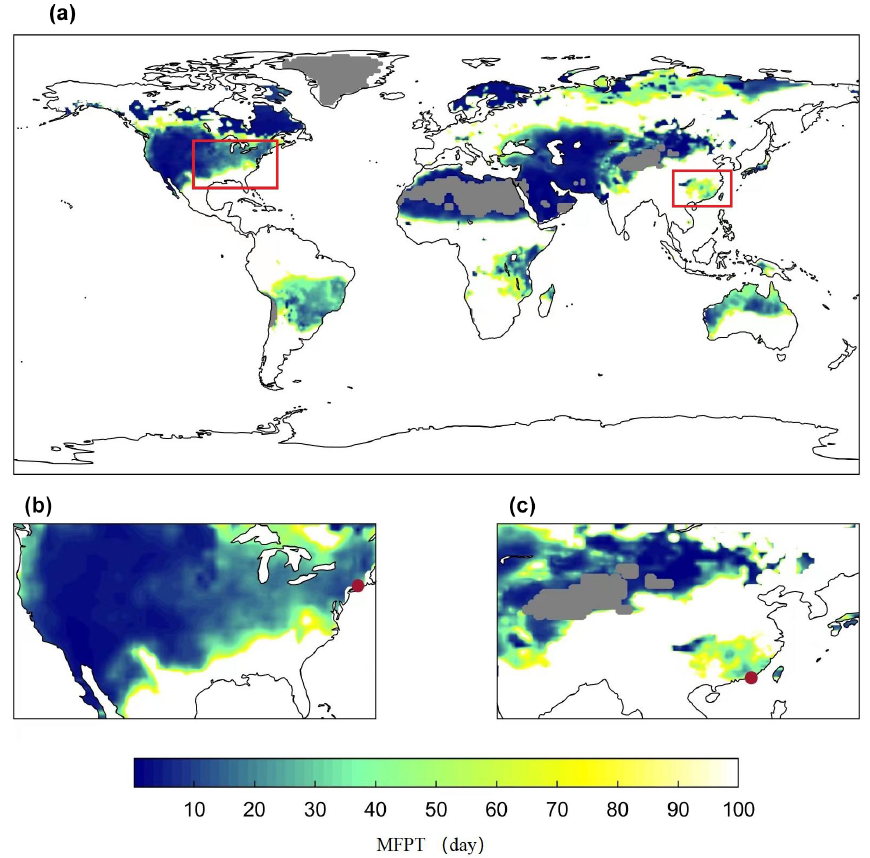
Figure 4. Global distribution of the mean first passage time (MFPT) in summer. The red boxes in panel (a) indicate the magnified areas in panels (b) and (c) , where New York state, USA (74 ◦ W, 44 ◦ N), and Heyuan city, Guangdong province, China (115 ◦ E, 24 ◦ N), are marked by red dots. The gray areas are hyper-arid regions, and other colored areas are those for which the MFPT of soil moisture drops from the 40th to the 20th percentile in fewer than 100d. Desert regions (gray areas) are excluded from this